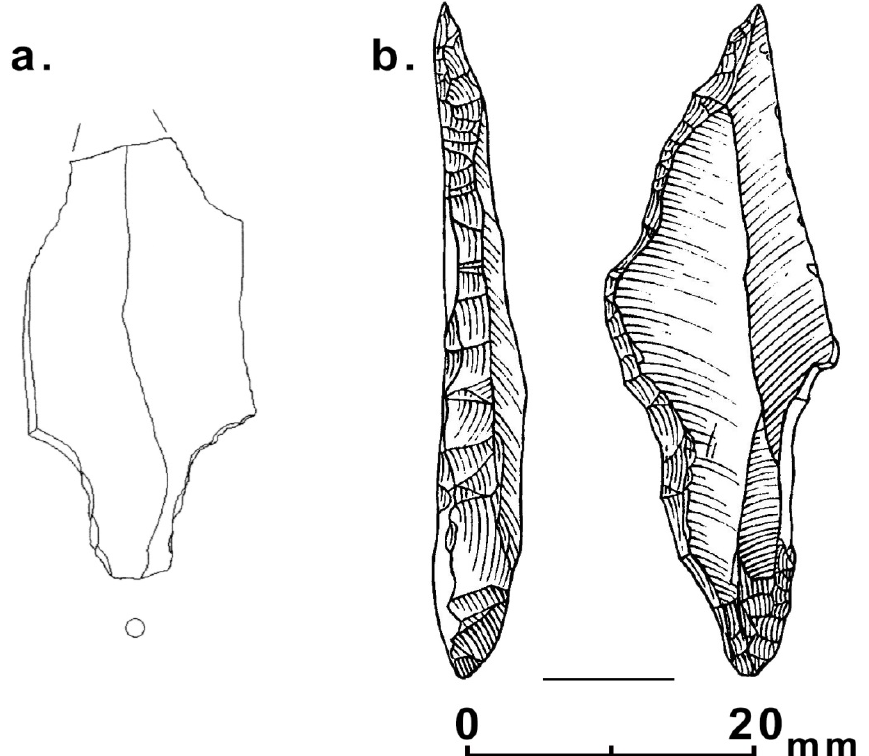
Figure 1. The expedient tanged point from Stronsay (redrawn from online illustration; SFLPS 2011) and the more sophisticated Ahrensburgian point from Tiree (drawing by Marion O’Neil; from Ballin & Saville 2003 (after Morrison & Bonsall